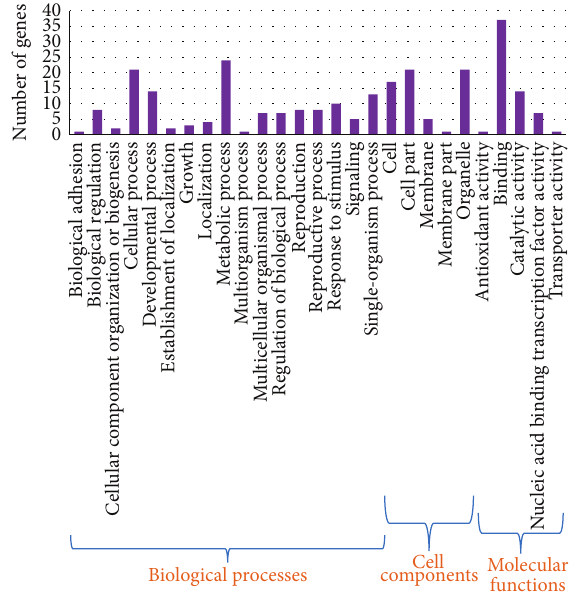
Figure 4: GO (level 3) annotation of predicted targets. Violet bar indicates the number of targets involved in each